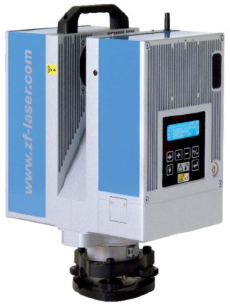
Figure 2. Terrestrial laser scanner ZF 5006h